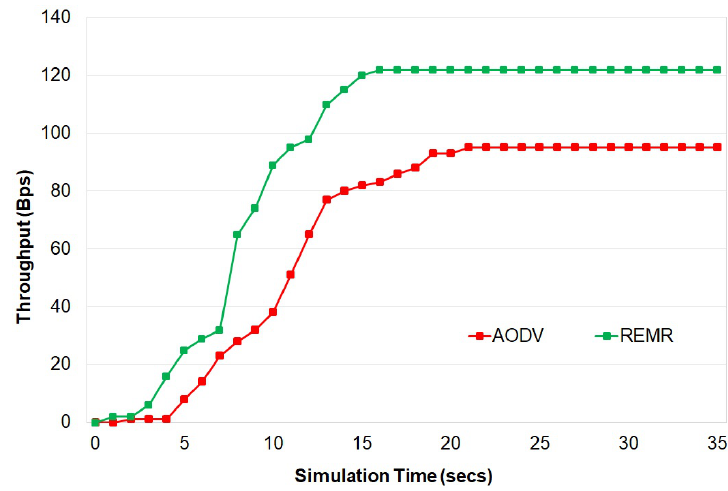
Figure 3. Throughput of AODV and